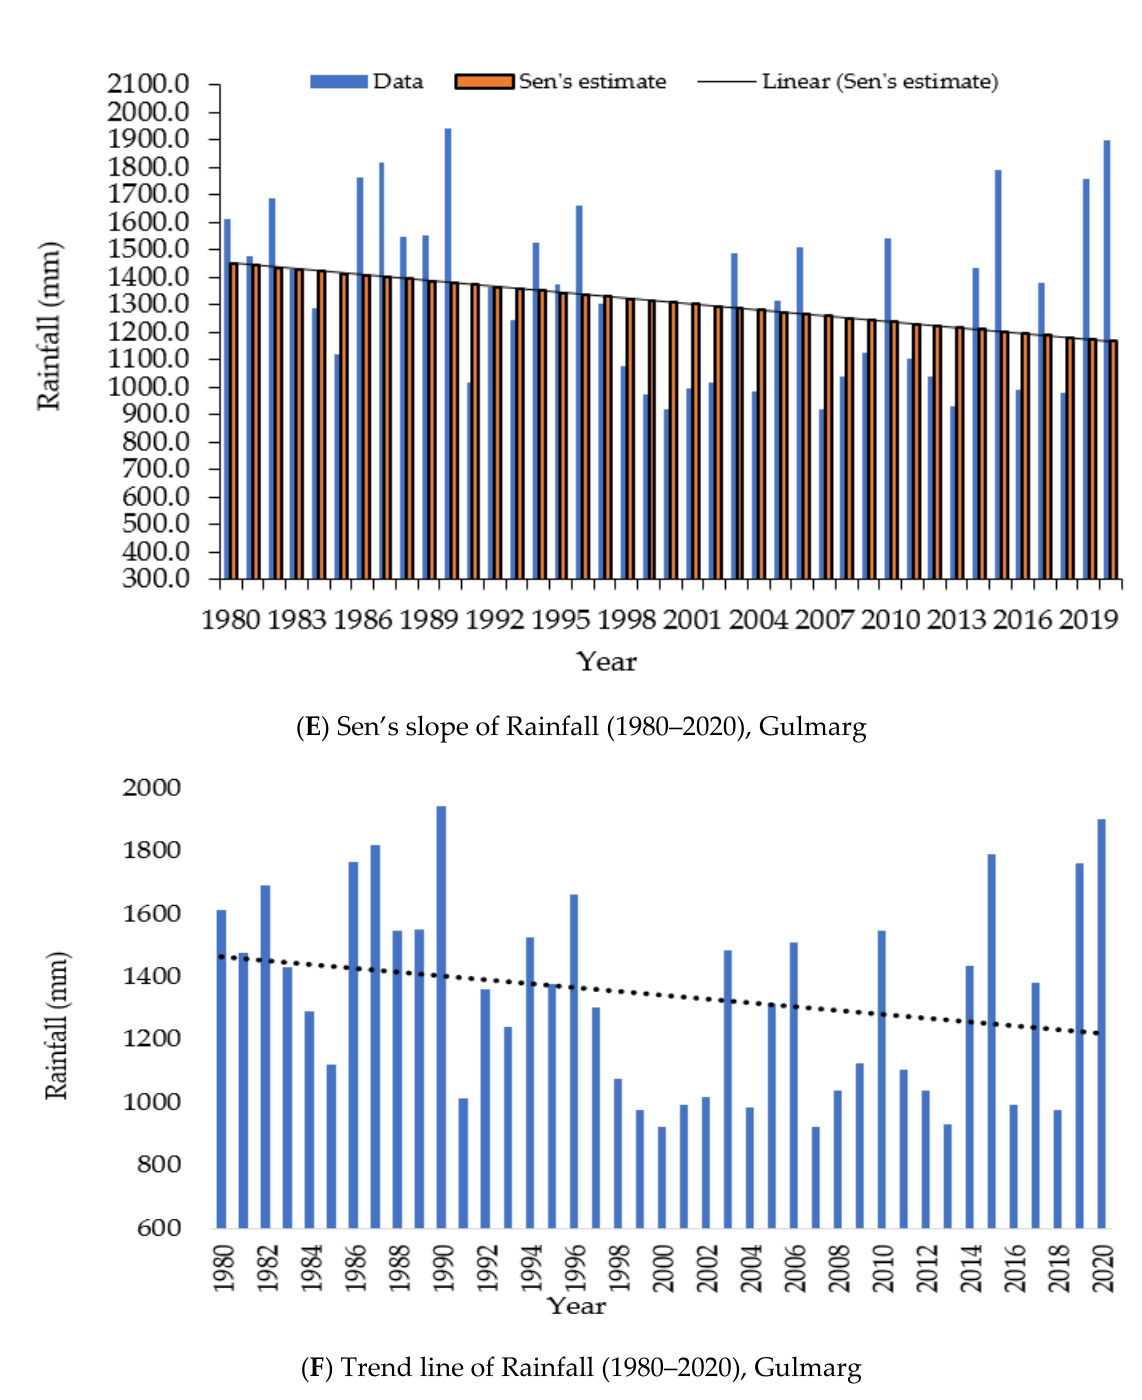
Figure 5. Descriptive statistics of weather parameters viz., Maximum and Minimum temperature and rainfall of location Gulmarg